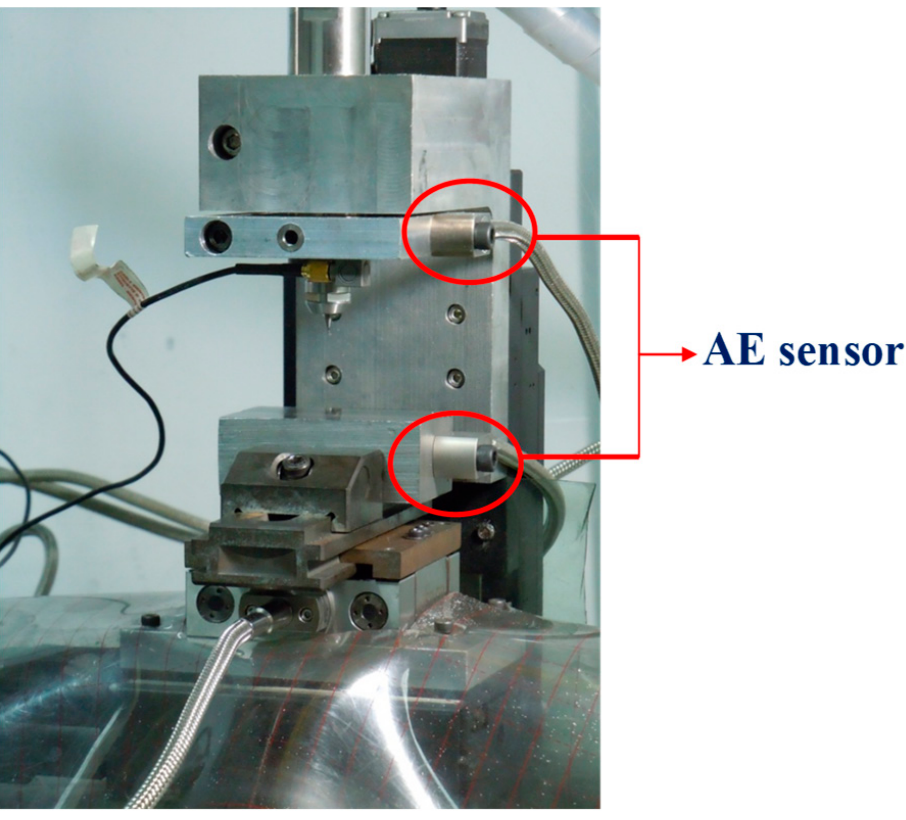
Figure 4. Experimental set-up for sensors in micro-milling. Table 1. Dimension of micro end mill.